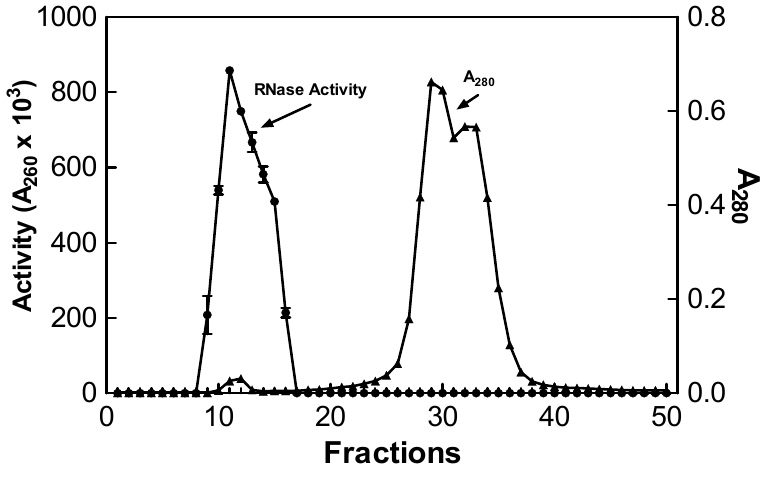
Figure 2. Typical plots of protein and enzyme activity when 1 mL of concentrated sample was passed through a Sephadex G-50 column at 2–5 °C. The activity was measured using the acid soluble assay at 55 °C and protein was estimated by determining the absorbance at 280